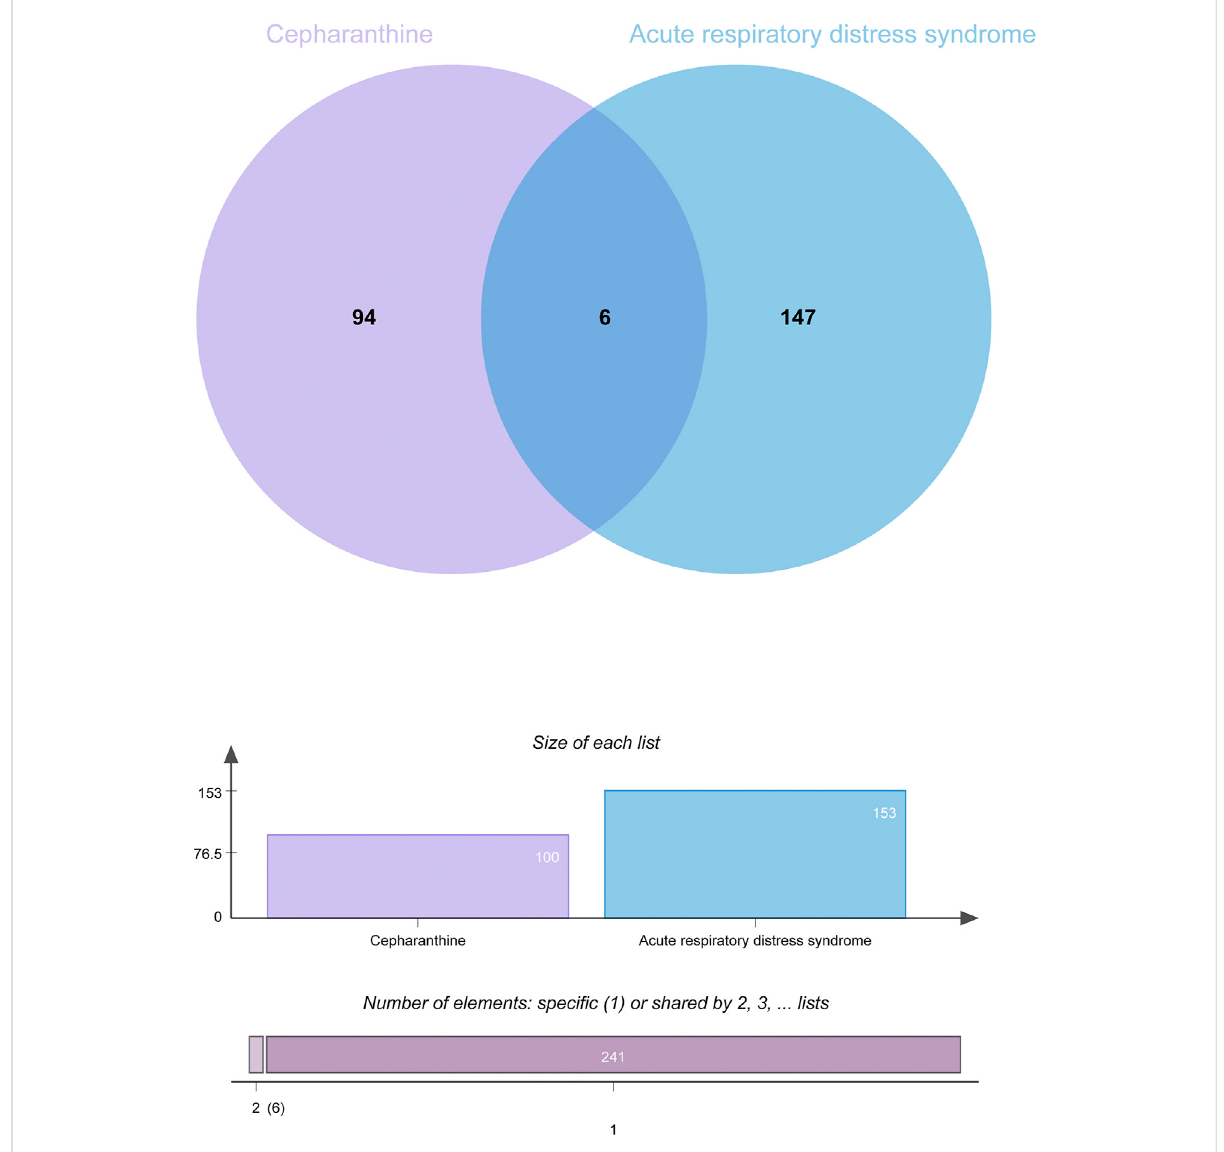
FIGURE 2 Venn diagram of the interactions of CEP targeted genes and genes associated with